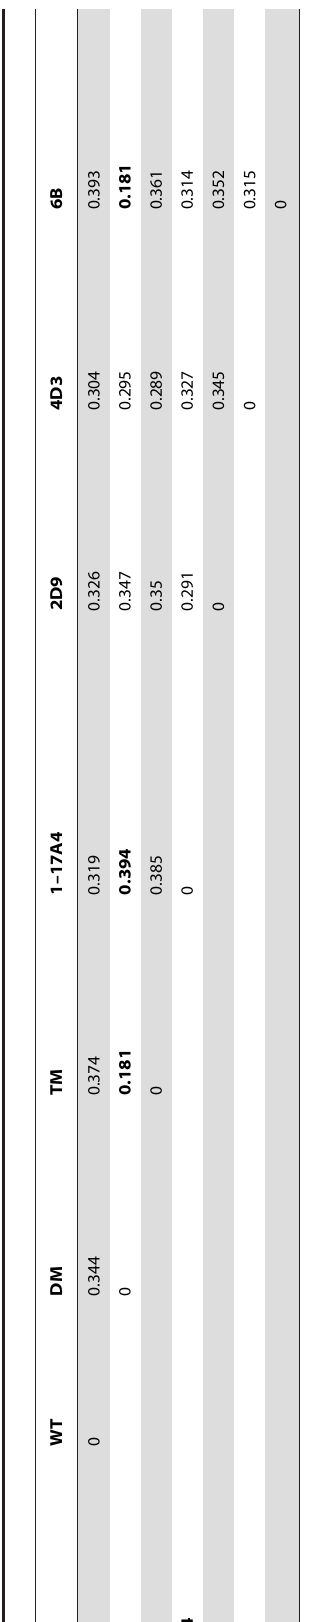
Figure 3. Residue-wise difference between then BC values of the mutants and